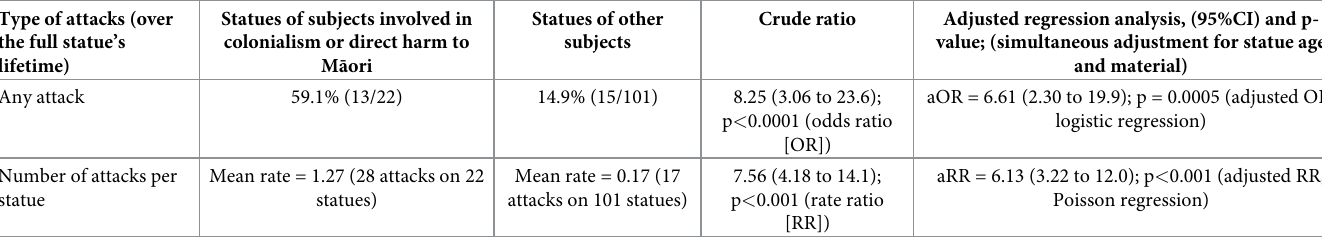
Table 4. Risk of attack by statue subject being involved in colonialism or direct harm to M ā ori, relative to other statue subjects. Type of attacks (over the full